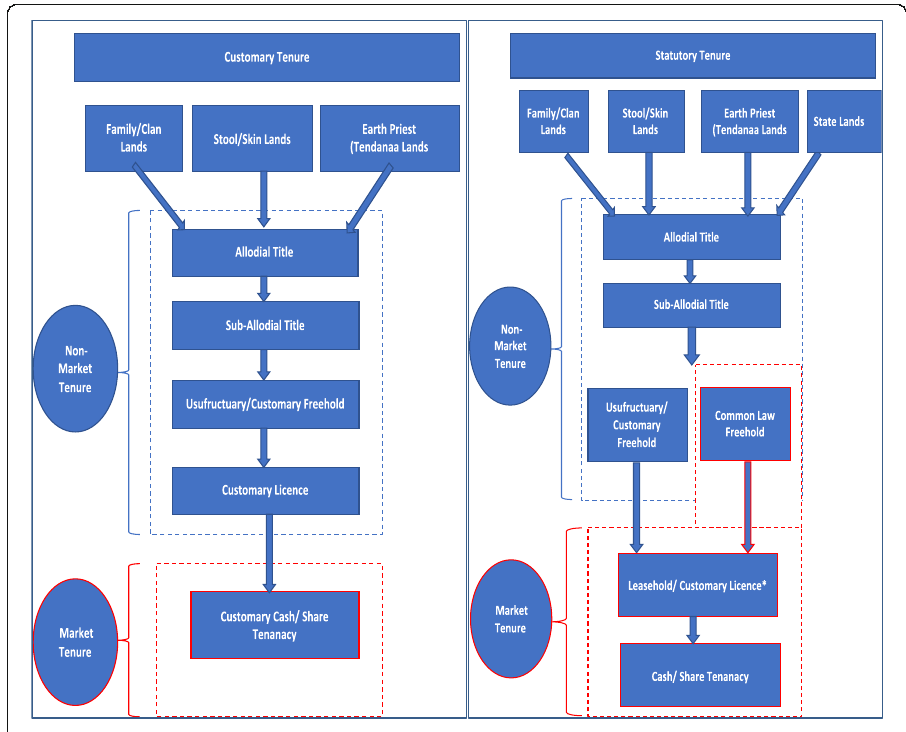
Fig. 1 Hierarchy of customary and statutory interests in land (Ghana). * The customary license devolves from the usufructuary, allodial or sub-allodial titles while the leasehold interest may devolve from the allodial, sub- allodial, usufructuary and common law freehold titles. Note: red lines indicate market-based tenure. Source: Authors ’ Illustration based on (Ollennu 1962; Bentsi-Enchill 1964; Asante 1965; Da Rocha and Lodoh